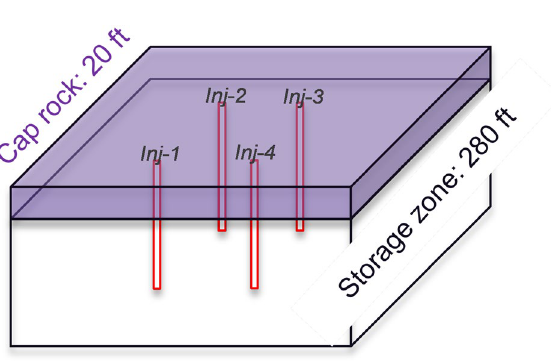
Figure 4. Schematic of the reservoir model for geological storage of CO 2 .